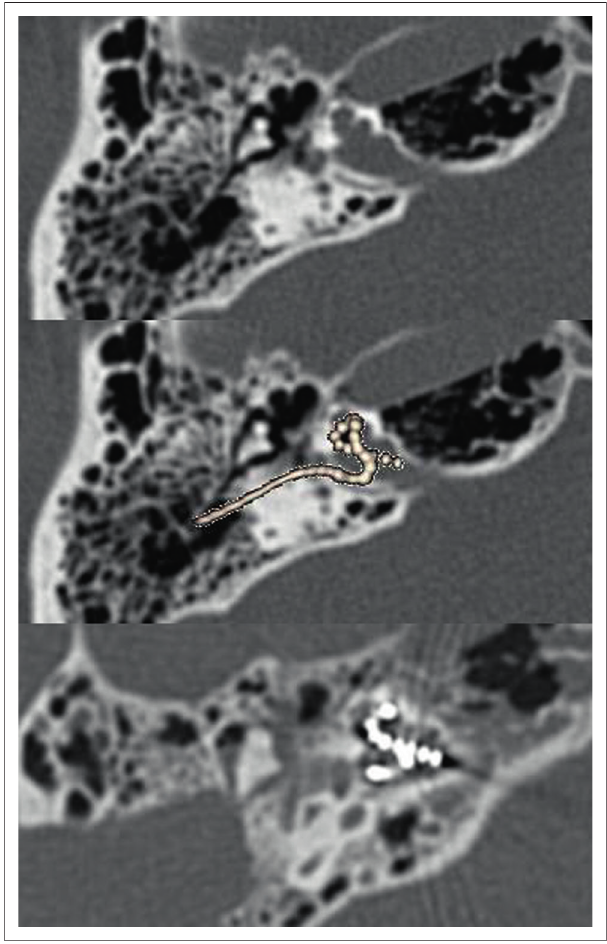
FIGURE 3: Preoperative (upper and middle images) and postoperative (bottom image) axial CT images of the right temporal bone, with abnormal positioning of the inserted cochlear implant electrode (volume rendering superimposed on the preoperative image, middle image), partially positioned in the internal auditory canal (bottom